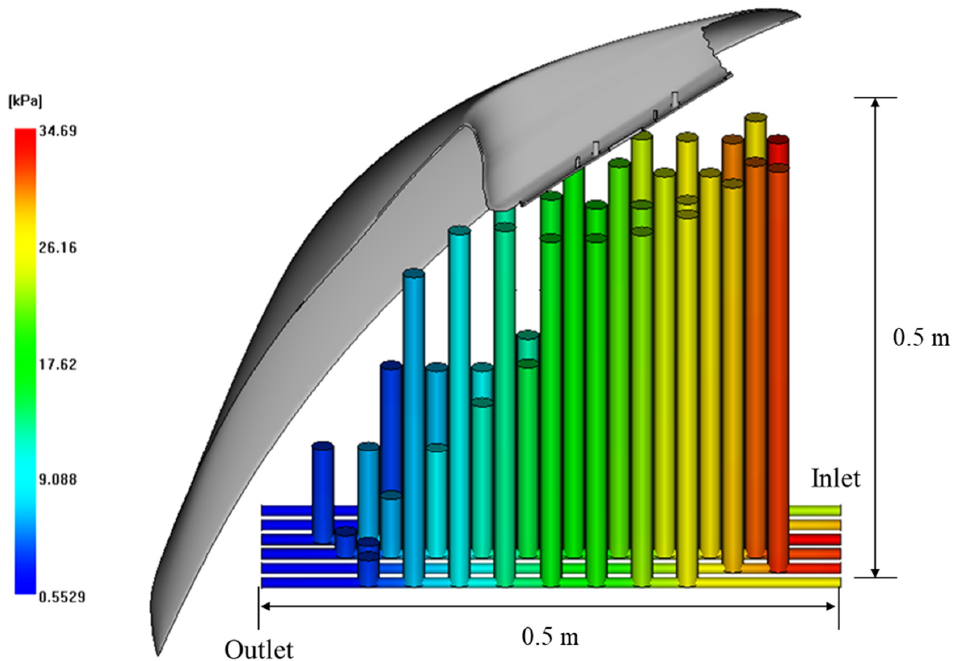
Figure 13. The pressure drop results using the straight-line cooling channels.